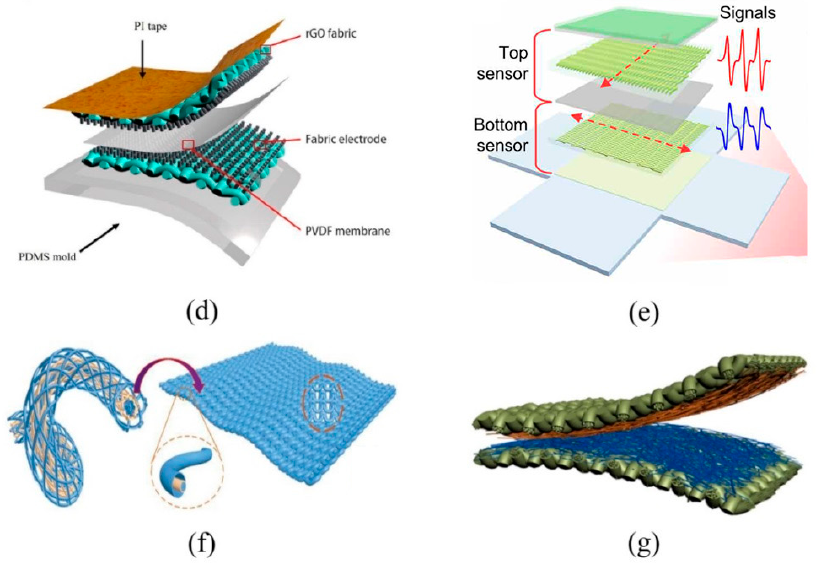
Figure 2. Schematic diagrams of TMSs configurations based on capacitive, piezoelectric, and triboelectric sensing mechanisms. PDMS means polydimethylsiloxane, PI means polyimide, rGO means reduced graphene oxide and PVDF means polyvinylidene fluoride. ( a ) sandwich structure fabric capacitive sensors, reproduced with permission from [47]; ( b ) crossed fiber capacitive sensors, reproduced with permission from [48]; ( c ) helix fiber capacitive sensors, reproduced with permission from [49]; ( d ) sandwich structure piezoelectric sensors, reproduced with permission from [50]; ( e ) double-layer piezoelectric sensors with vertical arrangement, reproduced with permission from [51]; ( f ) coaxial fiber triboelectric sensors, reproduced with permission from [52]; and ( g ) double-layer triboelectric sensors, reproduced with permission from ref. [53].